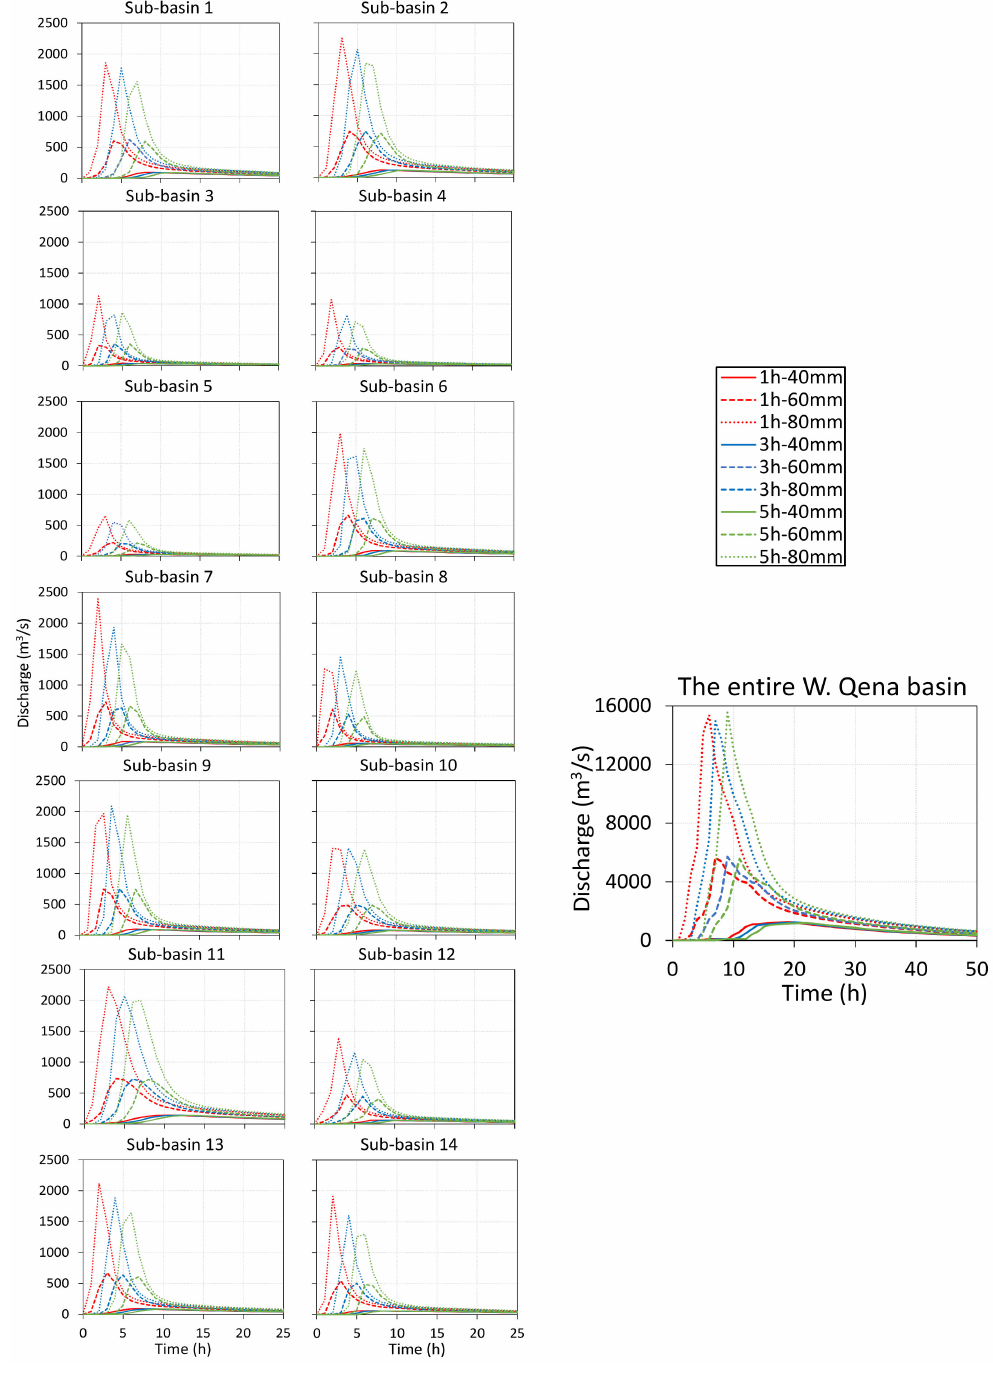
Figure 10. Simulated hydrographs at the different sub-basins outlets (sub-basin 1–14) and the entire Wadi Qena basin for the nine applied synthetic storm types based on total rainfall amount and